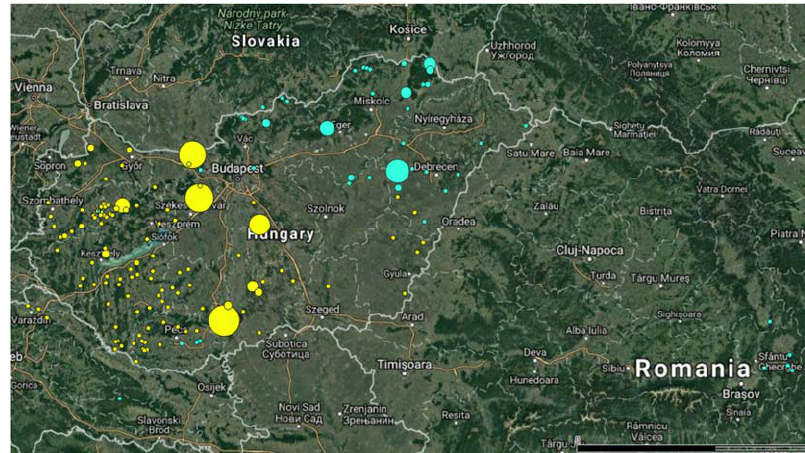
Figure 1. The geographic origin and genetic clustering of wild boar samples. The size of the circles represents the number of samples collected from a single hunting area. Blue dots: group 1 ( n = 147), yellow dots: group 2 ( n = 339).